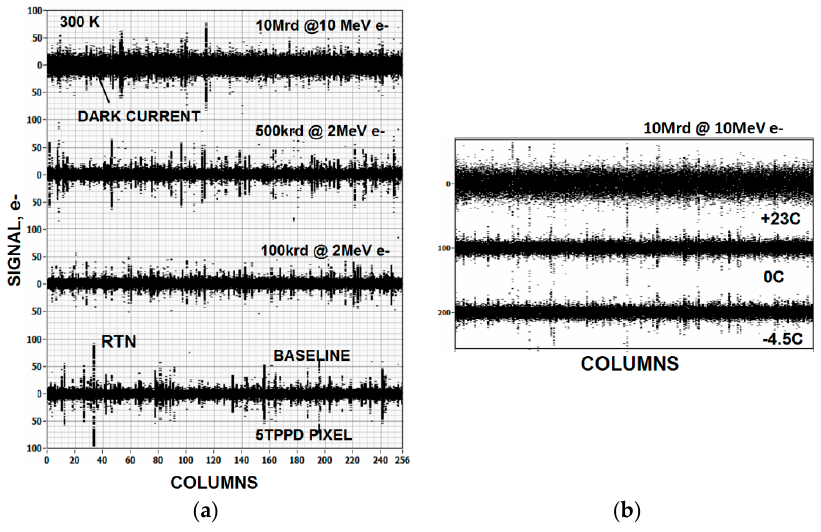
Figure 8. High energy electron damage source follower (SF) noise responses taken from a CMOS